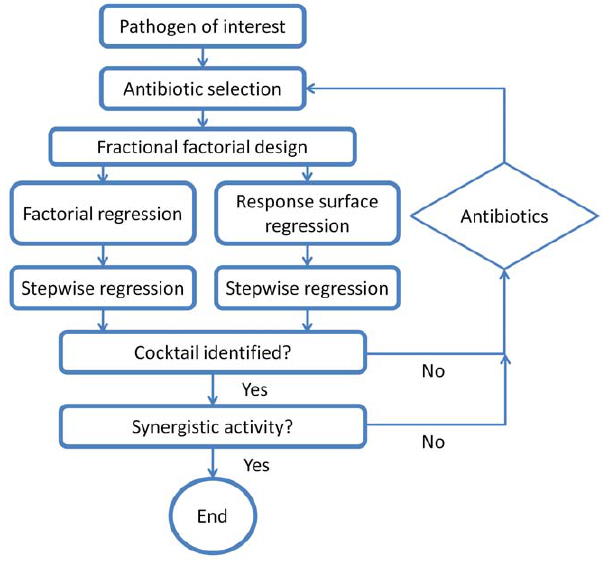
Figure 1. Flowchart representation of the metamodel antimi- crobial cocktail optimization (MACO) scheme for identifying potent antimicrobial cocktails. In the MACO scheme, the concen- tration levels of a set of antibiotics are first chosen based on a pathogen of interest. Fractional factorial design is then performed to select experimental trials that capture the main effects and interactions of antibiotics. Stepwise regression analysis is performed to extract the most effective cocktail in the parametric space. If a synergistic cocktail is identified, the cocktail can be tested for its synergistic activity. If not, the procedure can be repeated with modifications in antibiotics and concentration levels until a synergistic cocktail is identified.